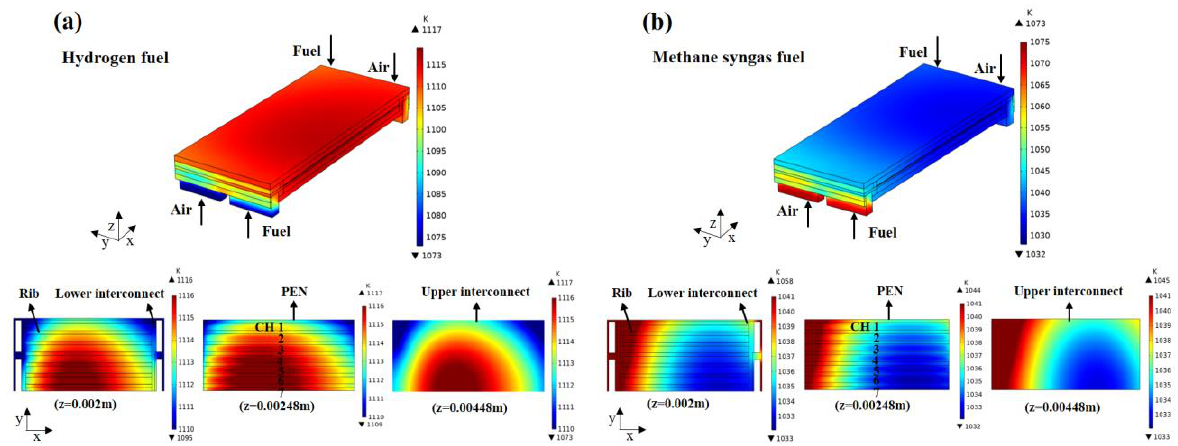
Figure 3. Temperature (K) distributions inside SOFC for: ( a ) hydrogen fuel; ( b ) methane syngas fuel.